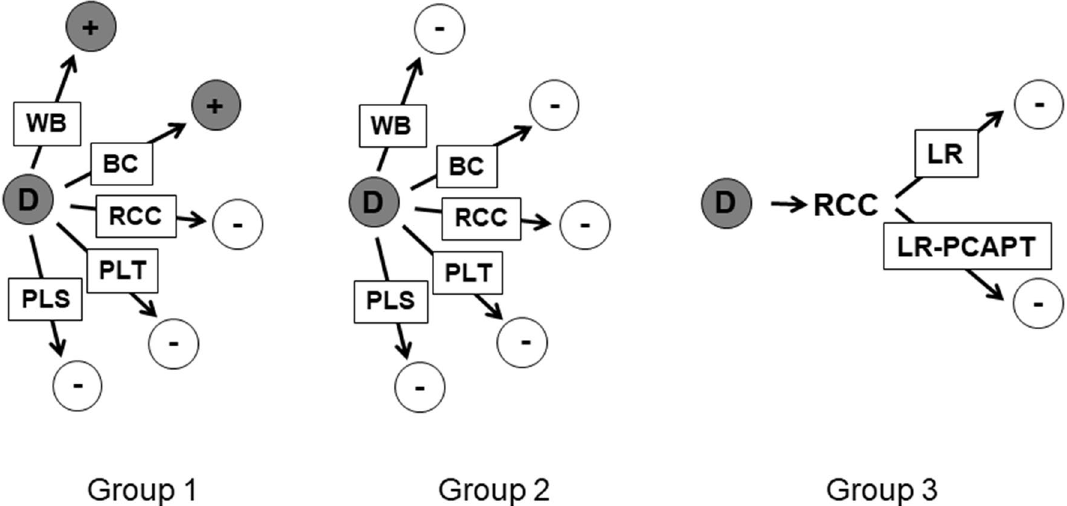
Figure 2. Schematic representation of sheep blood transfusion experiments . Whole blood (WB) was collected from BSE-infected donor sheep (D), processed into red cell concentrate (RCC), buffy coat (BC), plasma (PLS) and platelets (PLT), and each component transfused into an individual recipient sheep. In some cases, leucodepleted RCC, PLS, and PLT were also transfused, producing a cohort of 7 recipients per donor (WB was not transfused in these cases). Some recipients developed clinical signs of BSE and/or tested positive by Western blot/IHC (referred to as pathology positive; filled circles +), others did not develop clinical signs of BSE and/or tested negative by Western blot/IHC (referred to as pathology negative; open circles −). Group 1: some recipients were pathology positive. Group 2: no pathology positive recipients. Group 3: P-CAPT experiment: recipients transfused with leucodepleted (LR) or leucodepleted and P-CAPT filtered (LR-PCAPT) red cell concentrate (RCC). Details of the experimental design and results for all groups can be found in previous publications 15,16 .